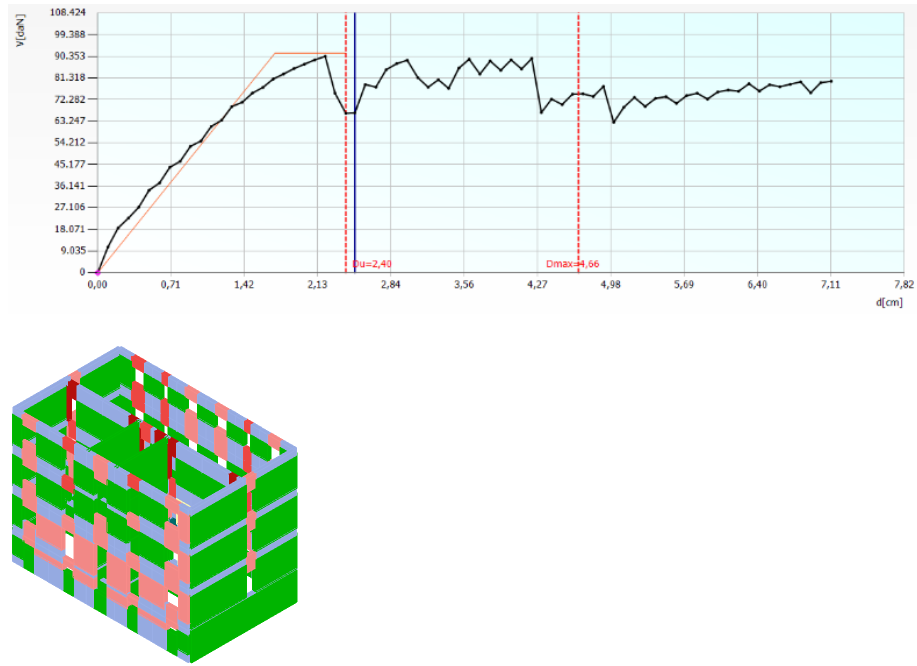
Figure 10. Base-shear displacement curves of the bare building derived from non-linear analyses.